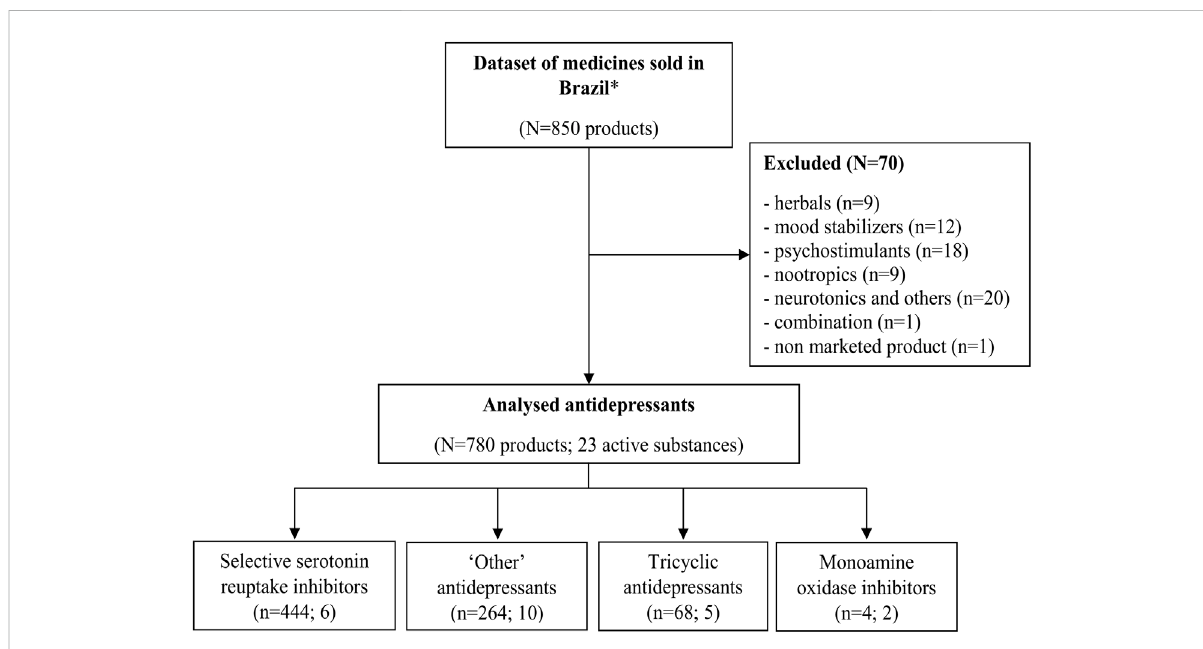
FIGURE 1 Antidepressant selection for analysis. Note: *N6 coded by EphMRA - psychoanaleptics excluding antiobesity